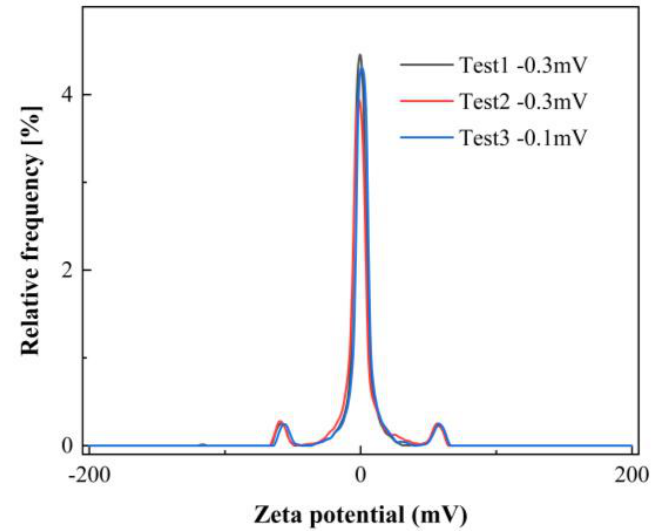
Figure 3. ζ -potential distribution of CQD-W.